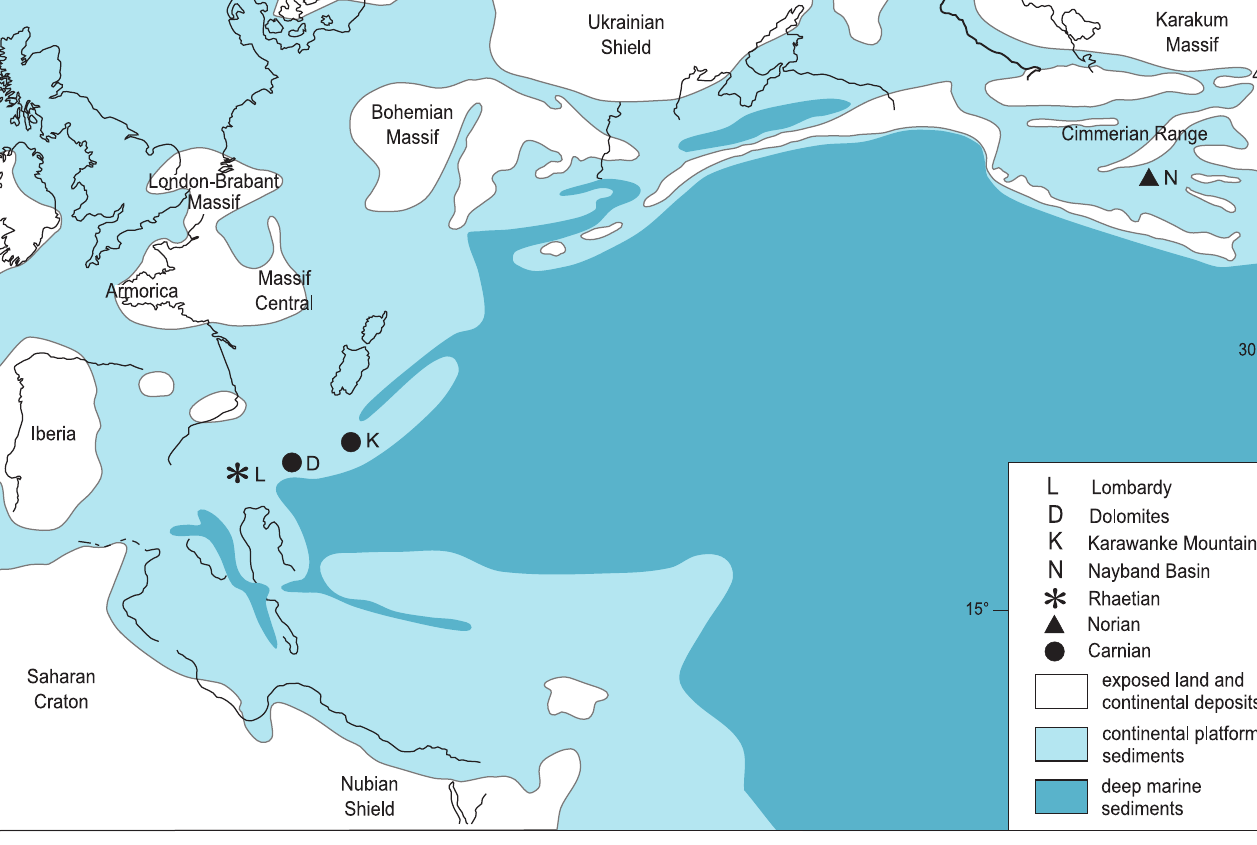
Fig. 5. Palaeogeographical distribution of Ederazyga during the Late Triassic. Map modified from the late Norian maps of Dercourt et al. (2000) and Barrier and Vrielinck